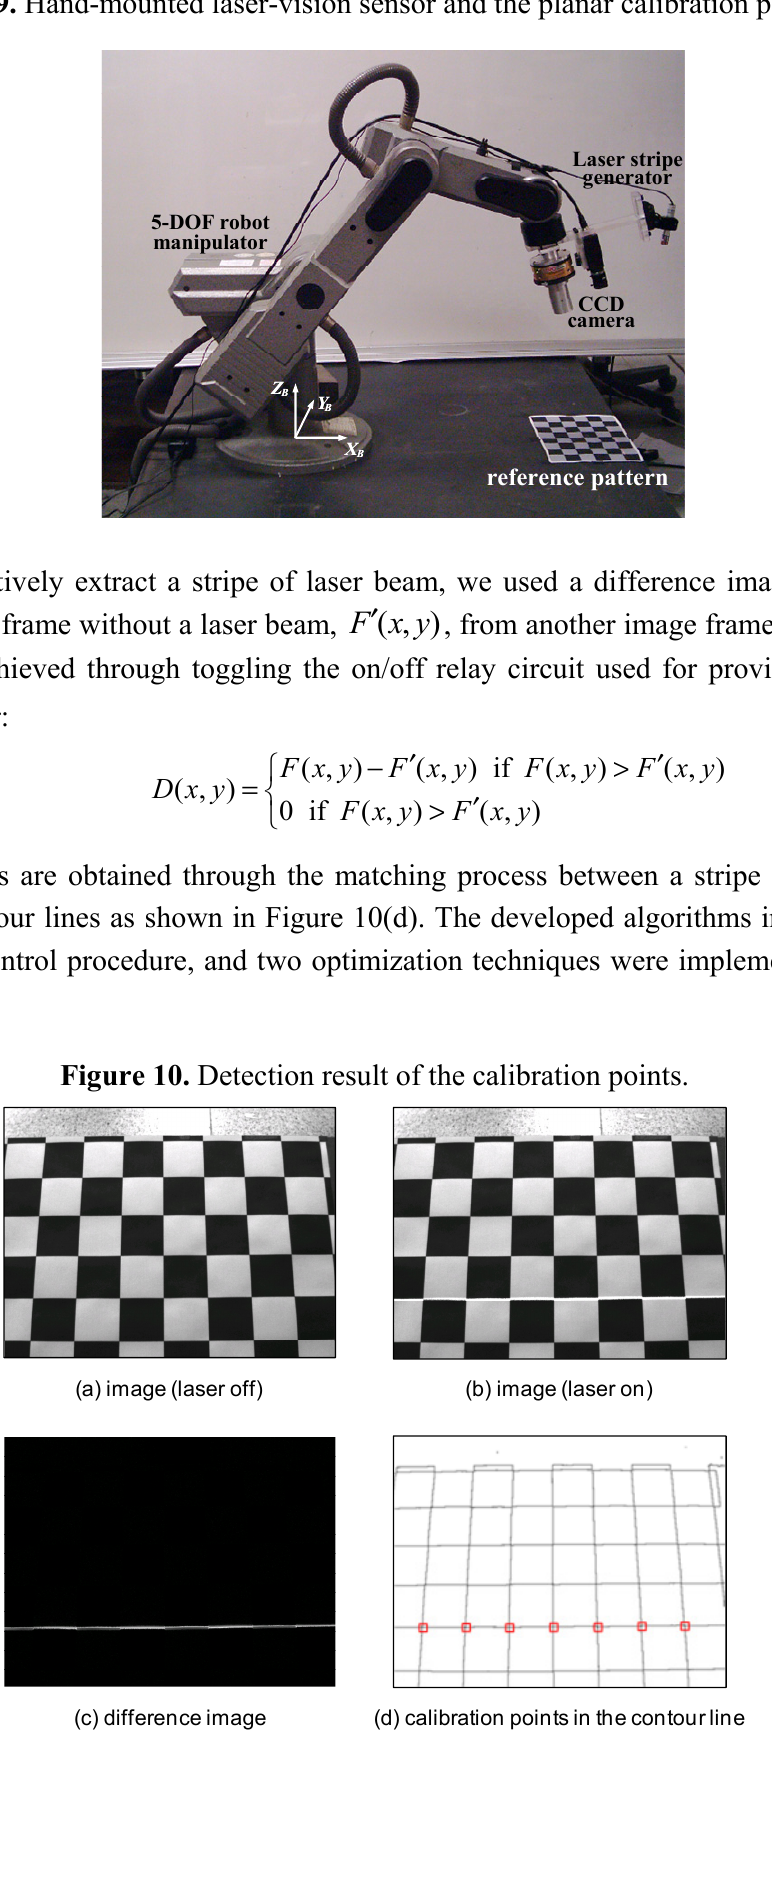
Figure 9. Hand-mounted laser-vision sensor and the planar calibration pattern.